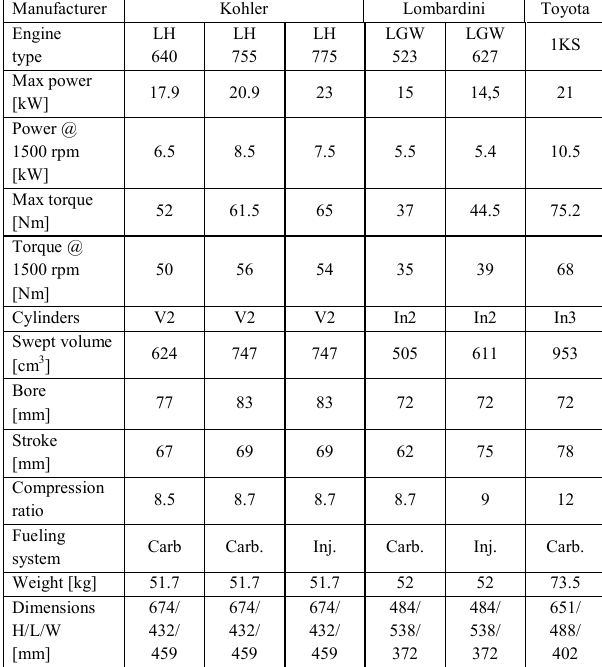
Table 1. Technical data of chosen SI